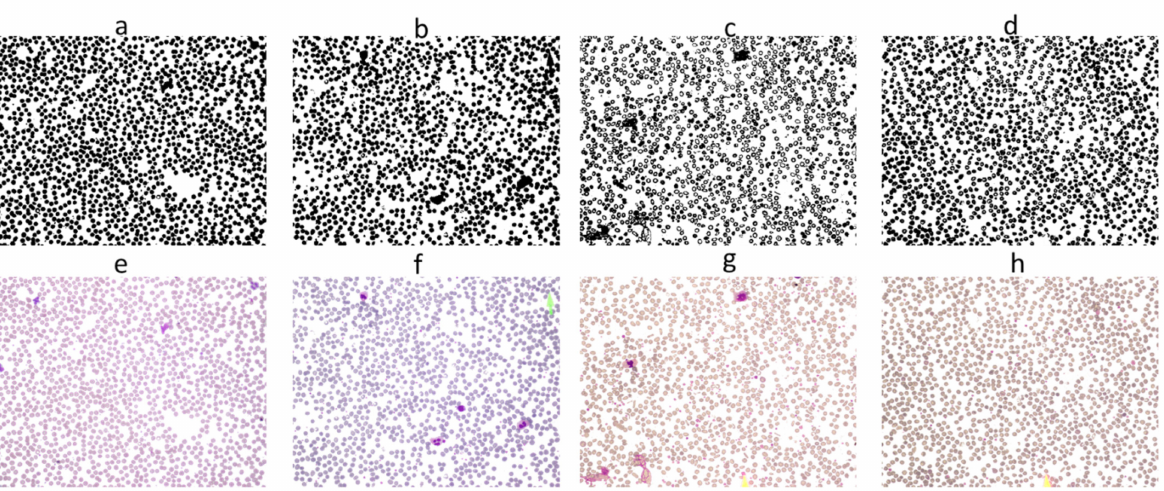
Figure 4. Images from ( a , b ) represent healthy binary RBCs images, ( c , d ) images are binary represen- tations of Anemic-RBCs, images from ( e – h ) represent pixel-level healthy and Anemic-RBCs